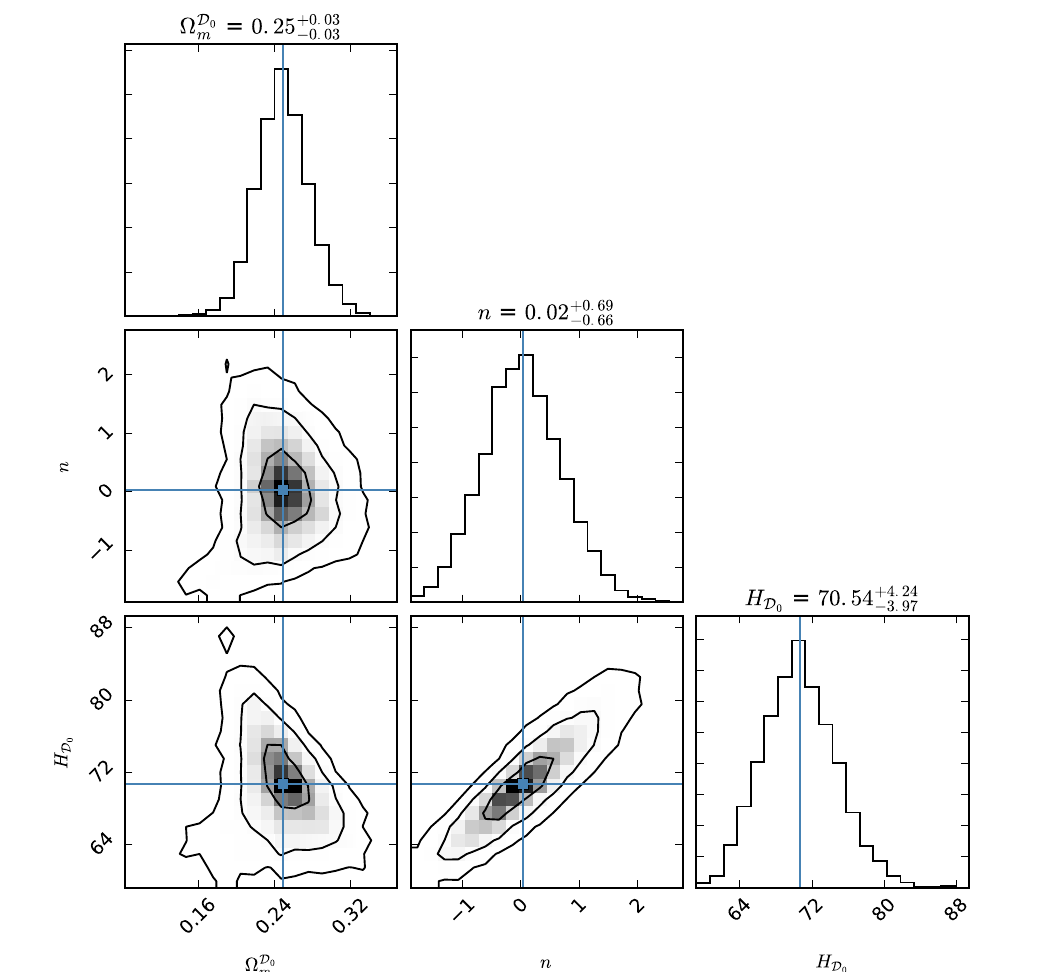
for the backreaction model, along with their own 0